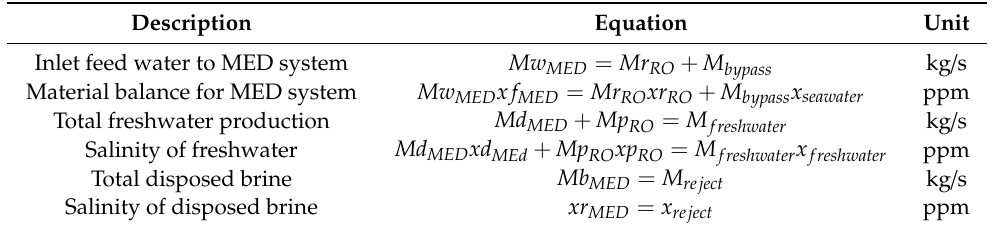
Table A4. Mathematical model of integrated multi e ff ect distillation-thermal vapour compression and reverse osmosis system [7].